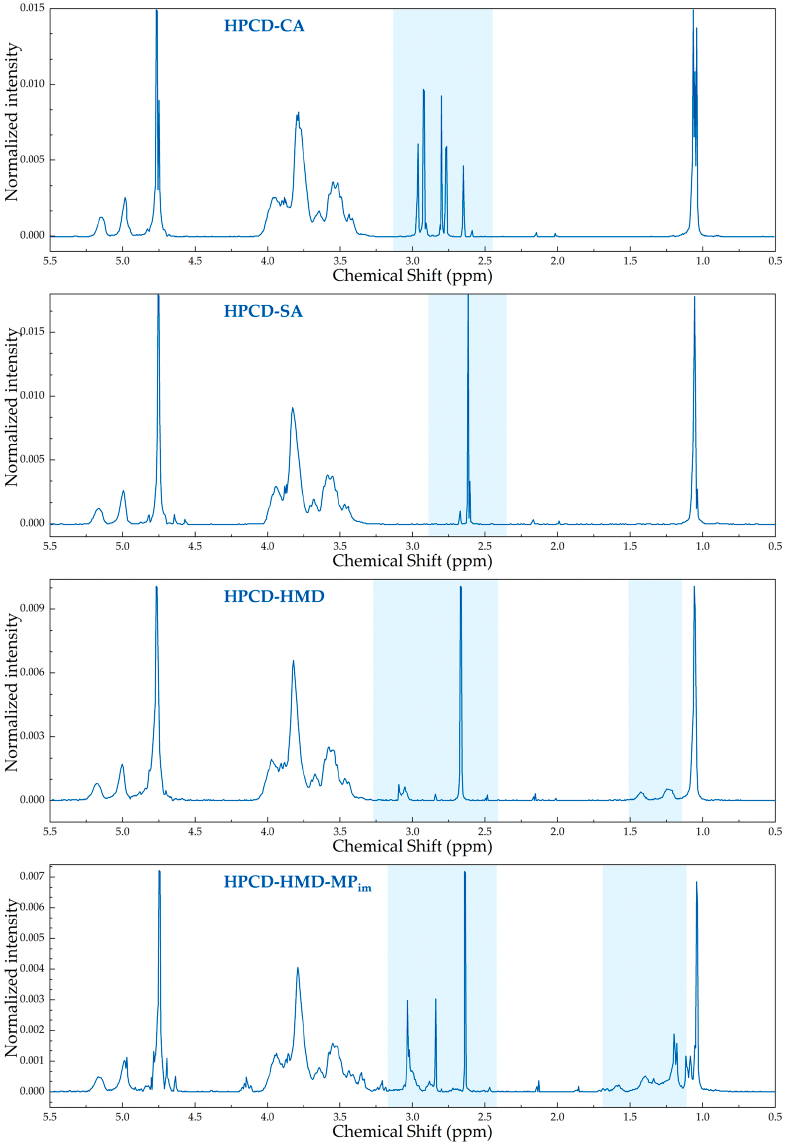
Figure 4. 1 H NMR of HPCD, HPCD-CA polymer, HPCD-SA acid polymer, HPCD-HMD, and HPCD-HMD-MP im , D 2 O, 400 MHz. The blue shading indicates the peaks corresponded to the linkers.